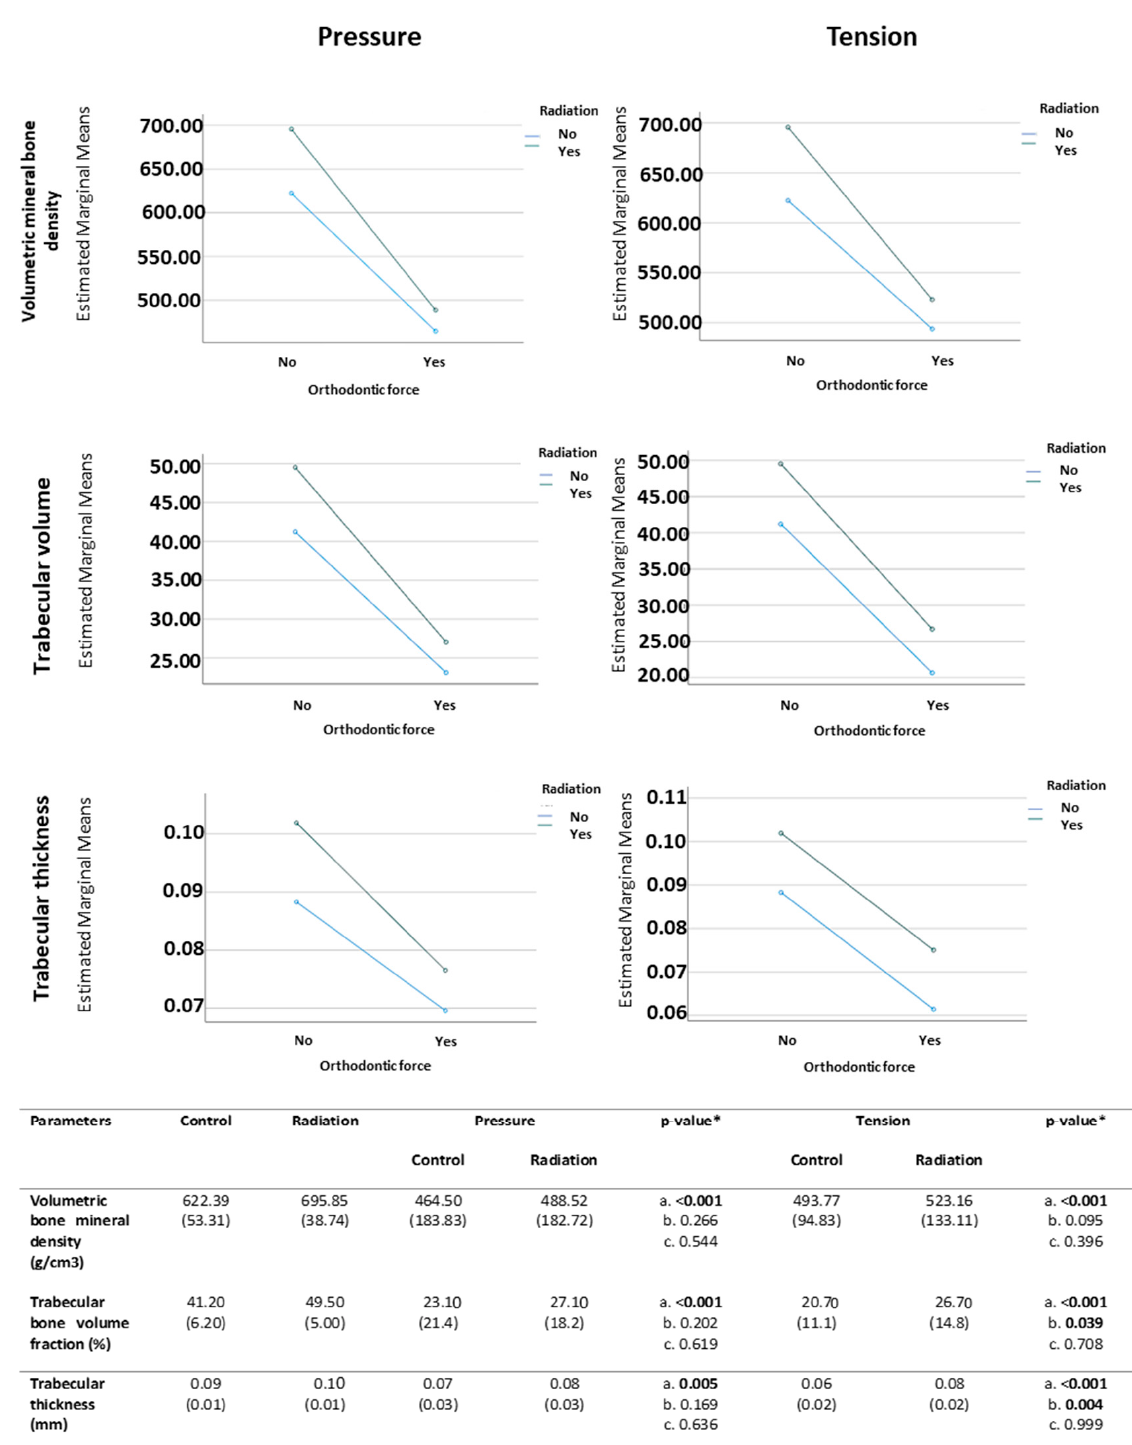
Figure 2. Microstructural changes in volumetric mineral bone density, trabecular volume, and trabecular thickness as a factor of orthodontic force and radiation.